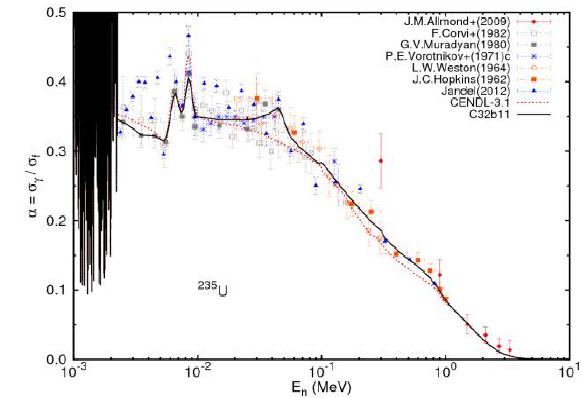
Fig. 13 . The comparison between the evaluated α values and the experimental data in EXFOR/CSISRS [20].